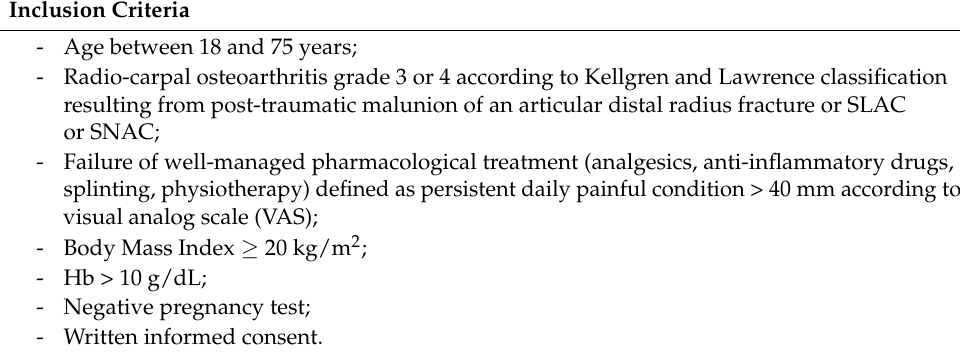
Table 1. Inclusion and Exclusion